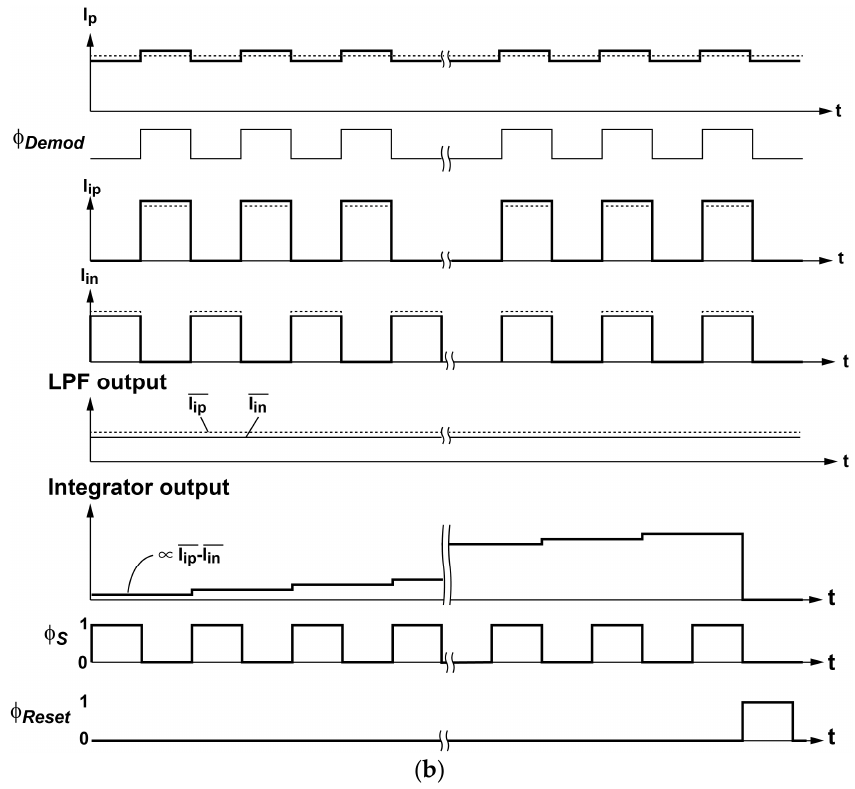
Figure 4. Lock-in Pixel Using a Two-Tap Demodulator: ( a ) block diagram ( b ) operation of the lock-in pixel.